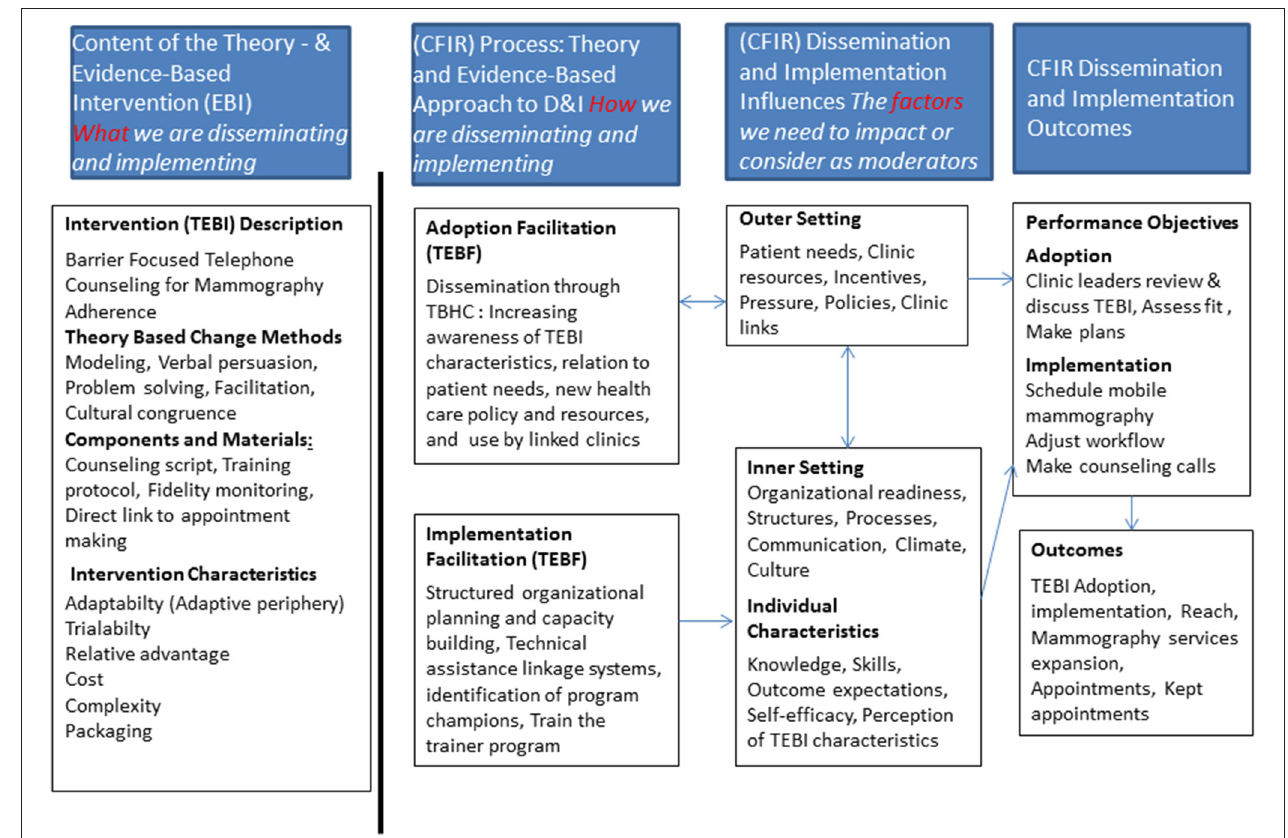
FIGURE 1 | Conceptual framework for development of